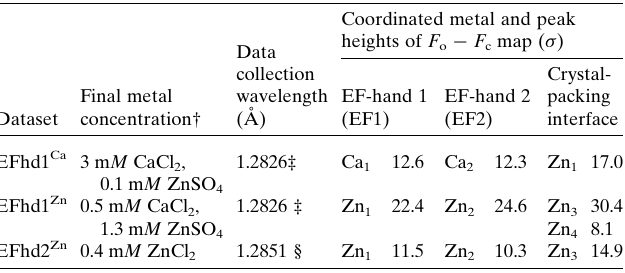
Table 2 Peak heights of the (cid:5) A -weighted mF o (cid:4) DF c ( F o (cid:4) F c ) map of EFhd1 Ca , EFhd1 Zn and EFhd2 Zn .